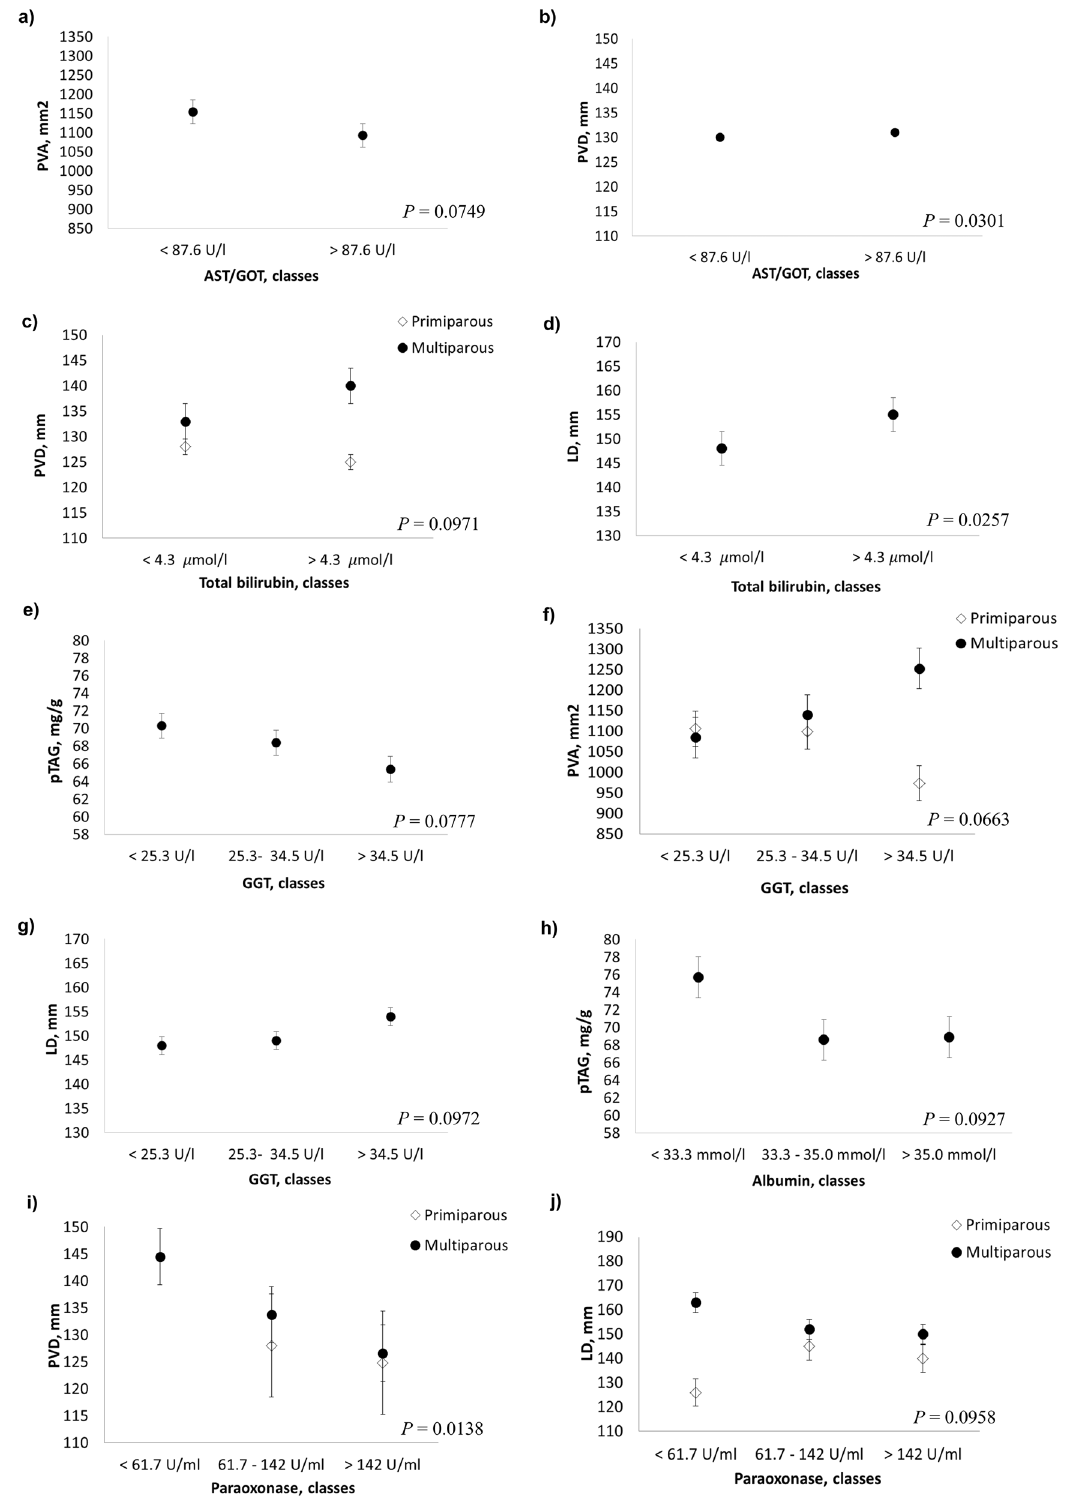
Figure 3. Least squares means (LSM) for predicted liver triacylglycerol (pTAG), portal vein area (PVA), portal vein depth (PVD) and liver depth (LD) across the classes of liver functionality hematic parameters. ( a , b ) AST/ GOT; ( c – e ) GGT; ( f , g ) total bilirubin; ( h ) albumin; ( i , j ) paraoxonase. Black dots/rhombus indicate the LSM and error bars indicate the standard